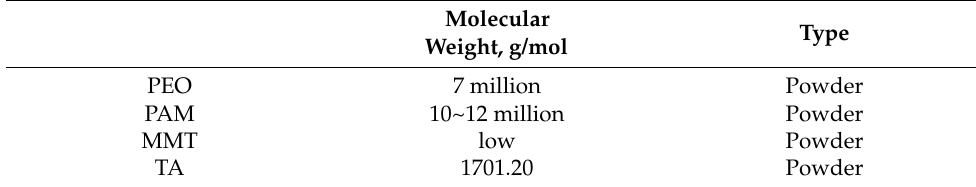
Table 1. Flocculants/Cofactors used in this